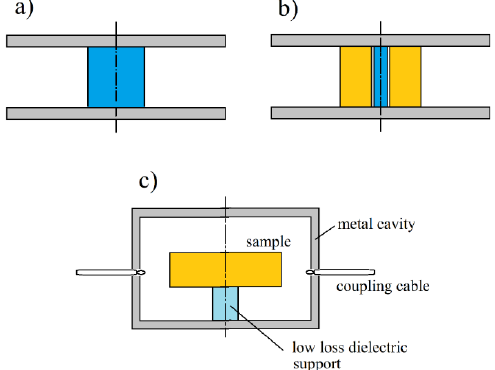
Figure 3. TE 011 mode dielectric resonators ( a ) Hakki–Coleman cell [23] for measurements of low loss dielectrics, ( b ) cylindrical dielectric resonator for measurements of high permittivity high loss samples [25] and measurements of the initial permeability of ferrites [27], ( c ) TE 01 δ mode dielectric resonator inside cylindrical metal shield [28]. The same resonance structure can be used for measurements of higher-order quasi TE 0 np [29] and whispering gallery modes [37,38] at higher frequencies.